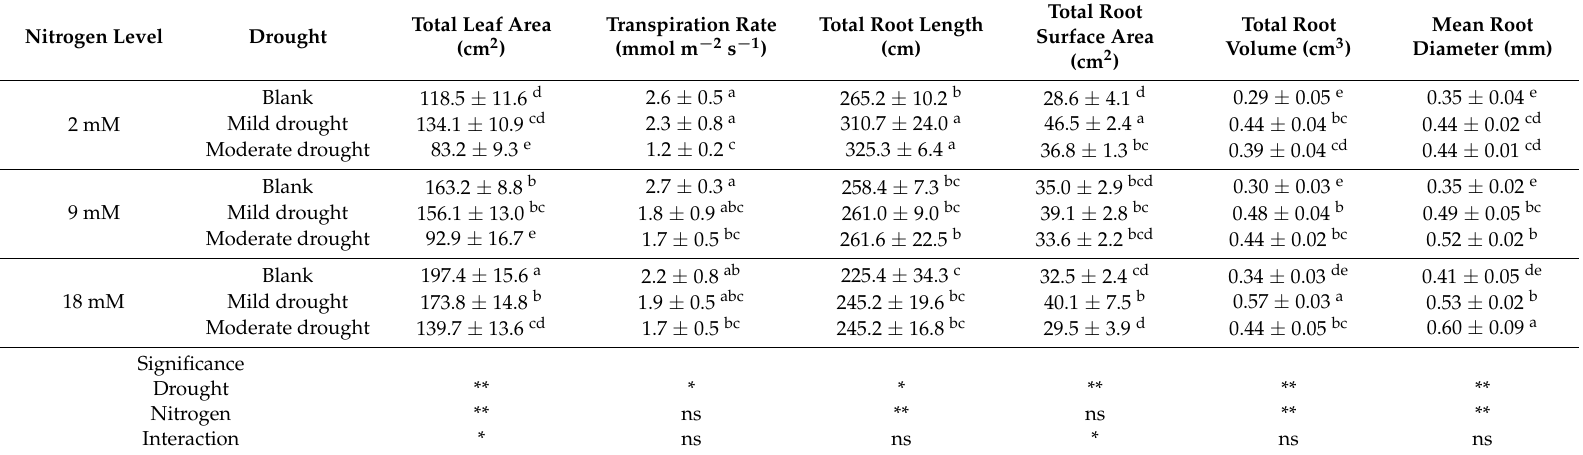
Table 1. Growth parameters and transpiration of pakchoi under different drought and nitrogen